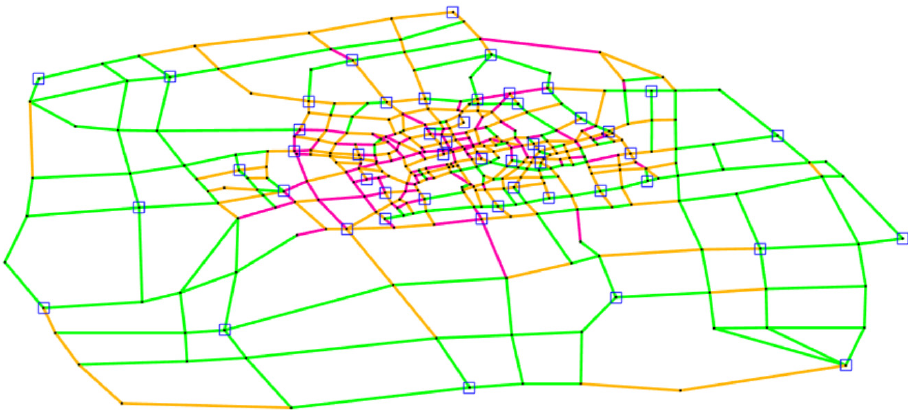
Figure 9. Topology of analyzed Shanghai transportation network with charging stations.